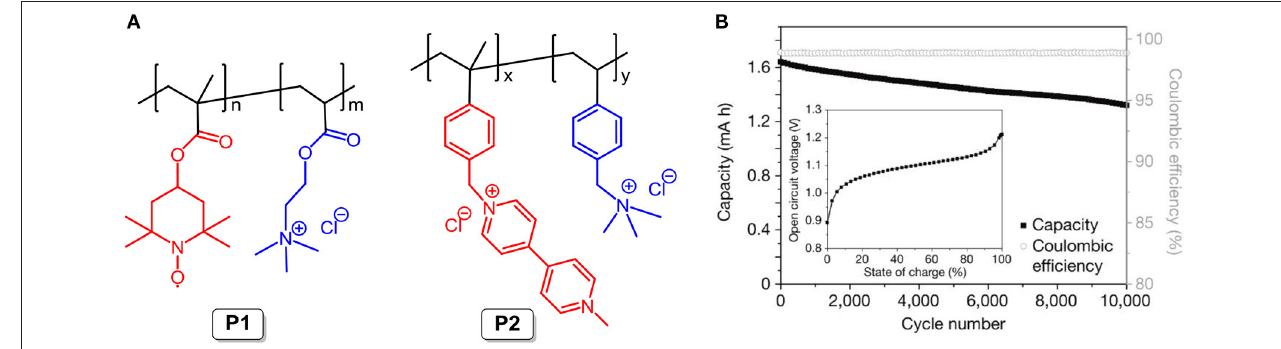
FIGURE 8 | (A) Molecular structures of P1 and P2 . (B) The long-term stability of the polymer-based electrolytes was studied by repeated charge/discharge cycling over 10,000 cycles at 20mA cm − 2 in an unpumped test cell (inset) the open-circuit voltage of a polymer-based RFB as a function of the state of charge. Reproduced with permission from Janoschka et al. (2015). Copyright 2015, Springer Nature.